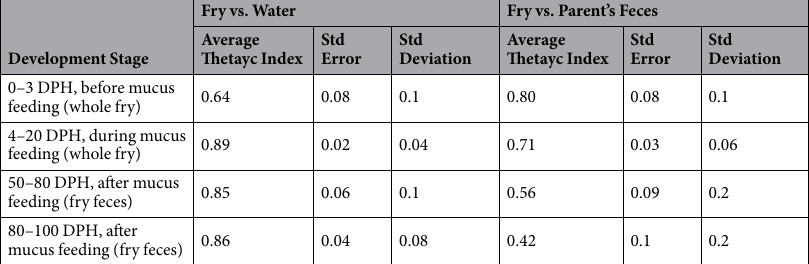
Table 1. Thetayc Index highlights convergence towards adult-like fecal microbiota and divergence from environmental water bacterioplankton through time. Results of the Thetayc Index analysis comparing